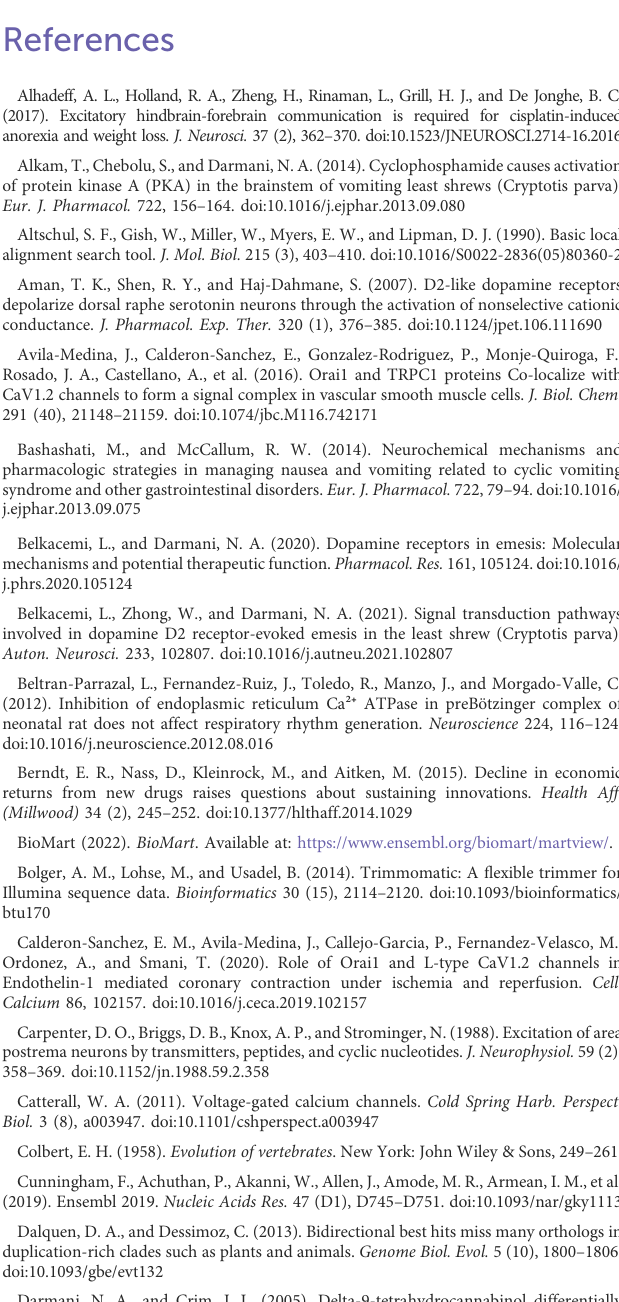
SUPPLEMENTARY TABLE S9 16,720 Shrew Transcript Sequences. File contains a set 16,720 shrew transcript sequences derived from brainstem and gut tissue that were assembled and mapped to orthologs. SUPPLEMENTARY TABLE S10 Emesis Pathway and Best Matching Transcripts Across Species. File contains a set of 39 emesis pathway components and their best hits to transcripts from human, dog, mouse, ferret and a related shrew species ( Sorex Araneus